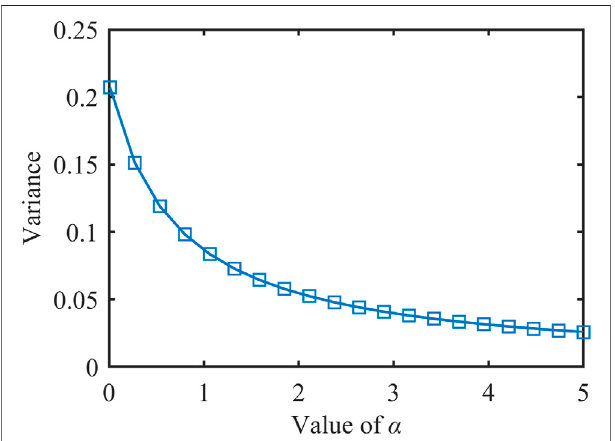
FIGURE 2 | The variance of different β distributions.